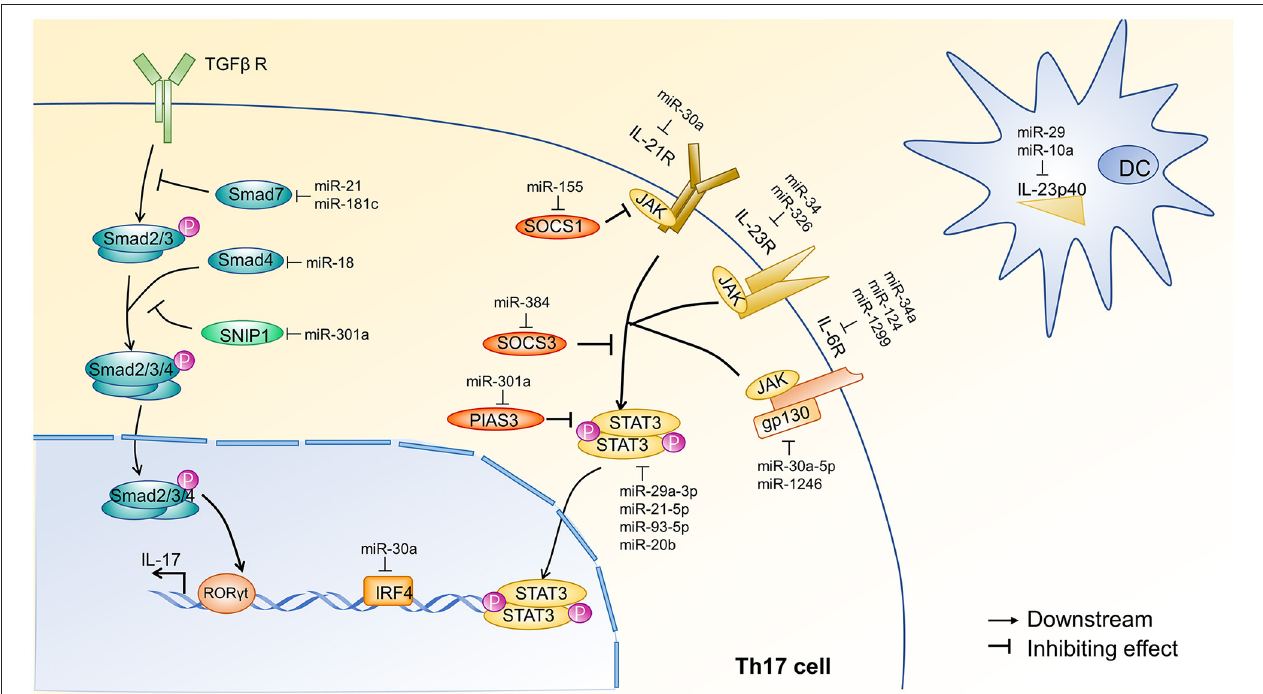
FIGURE 2 | miRNA regulation of TGF- β and JAK-STAT3 signal transduction pathways during Th17 cell differentiation. The initial activation of Th17 cell differentiation is driven by the synergistic effect of JAK-STAT3 and transforming growth factor- β (TGF- β ) signaling, which induce ROR γ t expression in naïve CD4 + T cells via two distinct mechanisms. JAK-STAT3 signaling is initiated by IL-6, IL-21, and IL-23. Dendritic cells (DCs) are the primary source of IL-23, and DC production of IL-23 is inhibited by miR-29 (33, 34) and miR-10 (35). Cytokine receptors on Th17 cells can also be inhibited by miRNAs. For example, miR-30a (36) inhibits IL-21R; miR-34a (37) and miR-326 (38) inhibit IL-23R; and miR-34a (37), miR-1299 (39), and miR-124 (40) inhibit IL-6R. Additionally, miR-30a-5p (39) and miR-1246 (41) target gp130, a component of the functional IL-6 family receptor complex. JAK-mediated phosphorylation of STAT3 occurs after cytokine receptor activation and is inhibited at various steps by SOCS1, SOCS3, and PIAS3. miR-155 ( 42), miR-384 (43), and miR-301a (44) target SOCS1, SOCS3, and PIAS3, respectively. Finally, STAT3 is directly inhibited by miR-29a-3p, miR-93-5p ( 45), miR-21-5p (46), and miR-20b (47). The TGF- β signal transduction pathway involves the sequential phosphorylation of Smad 2, 3, and 4, which ultimately induce IL-17 transcription. Smad7 and SNIP1 negatively regulate TGF- β signal transduction and are targeted by miRNA. Specifically, miR-21 ( 31) and miR-181c (32) inhibit Smad7, and miR-301a (30) inhibits SNIP1. Finally, miR-18 (29) can target Smad4. Of note, miR-30a (48) targets IRF4, another transcription factor required for the induction of ROR and IL-17A. Each of these pathways affects the expression of IL-17 in Th17 cells. Arrow heads indicate a downstream response, and blunt lines indicate inhibition. TGF- β R, transforming growth factor- β receptor; Smad, drosophila mothers against decapentaplegic protein; SNIP1, SMAD nuclear interacting protein1; ROR, Retinoid-related orphan receptor; IRF4, interferon regulatory factor4; IL-21R, Interleukin 21 receptor; IL-23R, interleukin 23 receptor; IL-6R, interleukin 6 receptor; JAK, Janus kinase; gp130, glycoprotein130; SOCS1, suppressor of cytokine signaling1; SOCS3, suppressor of cytokine signaling3; PIAS3, protein inhibitor of activated STAT3; STAT3, signal transducer and activator of transcription3; P, phosphate; DC, dendritic cell; IL-23p40, IL-12 subunit